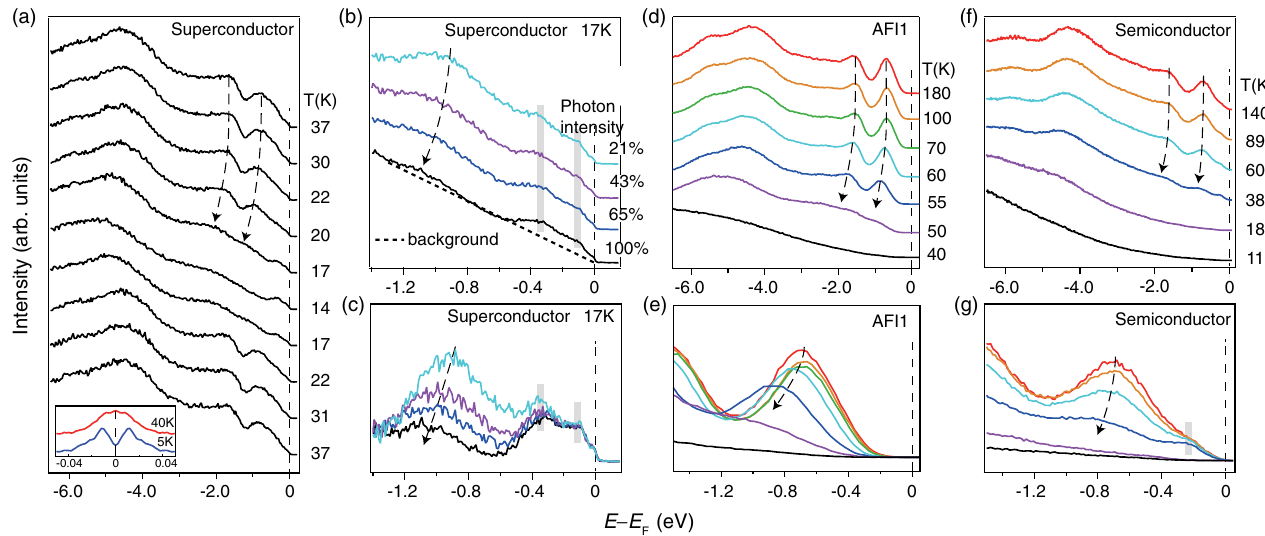
FIG. 2. Photoemission charging effects in K x Fe 2 (cid:1) y Se 2 . (a) Temperature dependence of the photoemission-energy-distribution curve (EDC) at the (cid:2) point of the superconductor. The inset is the symmetrized EDCs across T c , illustrating a superconducting gap of about 10 meVat the electron-Fermi surface around the zone corner. (b) EDC at the (cid:2) point of the superconductor as a function of the photon intensity. Data were taken at 17 K. (c) The EDCs after deducting the background [diagonal short-dashed line in (b)] to highlight the peak position shift due to the charging. (d) Temperature dependence of the EDCs at the (cid:2) point for the AFI1 sample. (e) The low- energy portion of data in (d). (f) and (g) are the same as (d) and (e), respectively, but for the semiconducting sample. The arrows on the dashed curves in all panels indicate the band shift with enhanced charging effects. The shaded bars in (b), (c), and (g) indicate charging-free